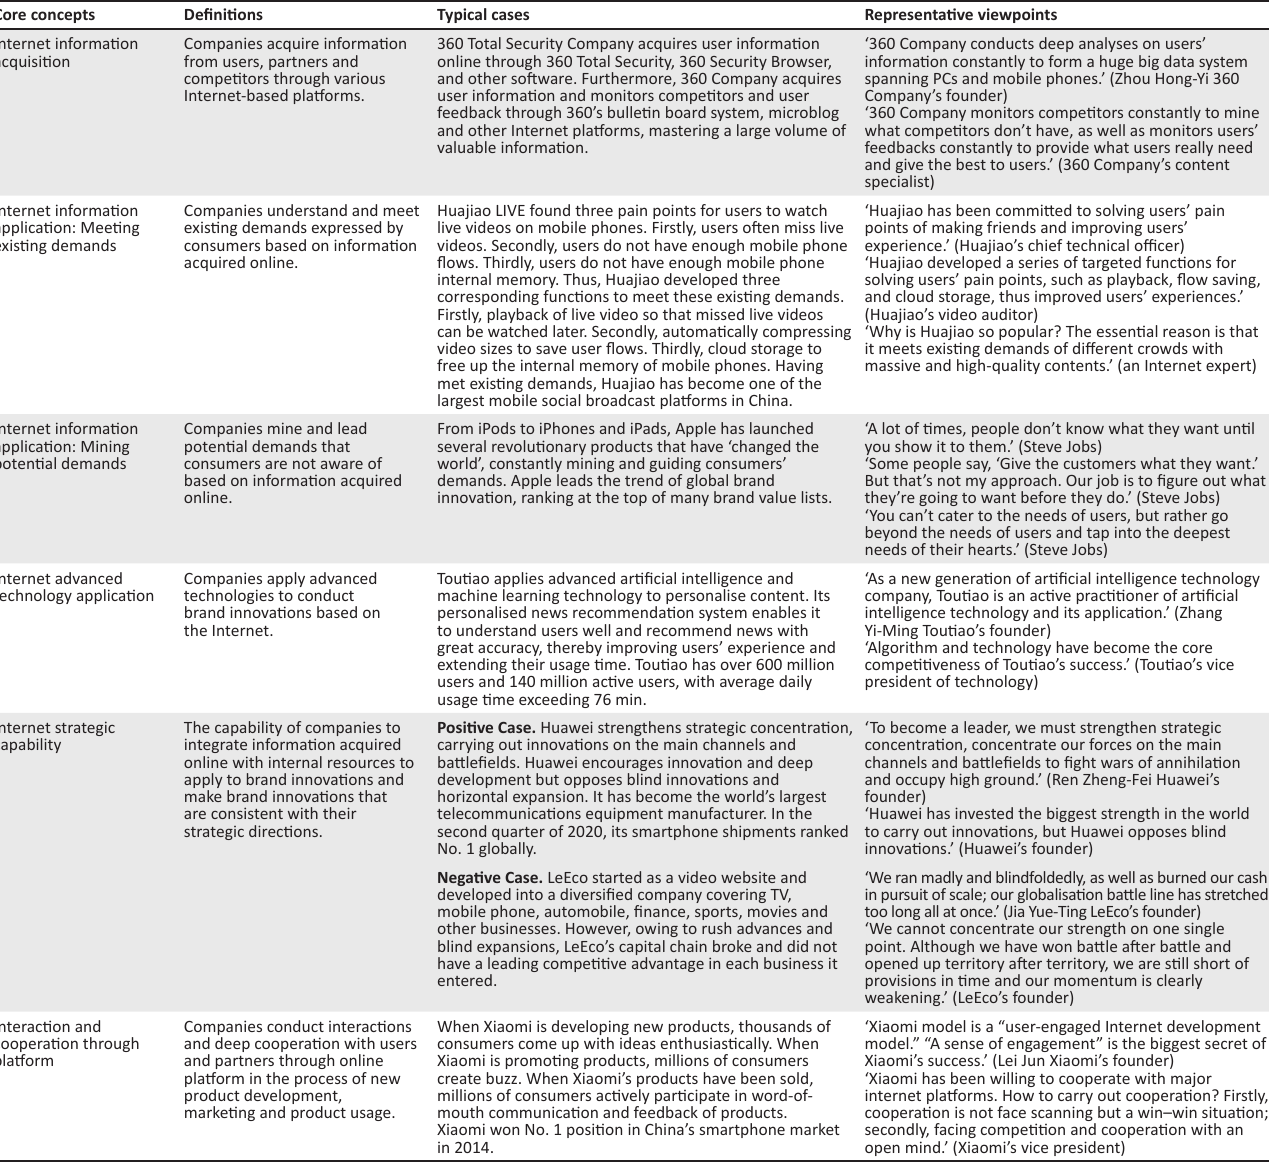
TABLE 1: Core concepts, typical cases and representative